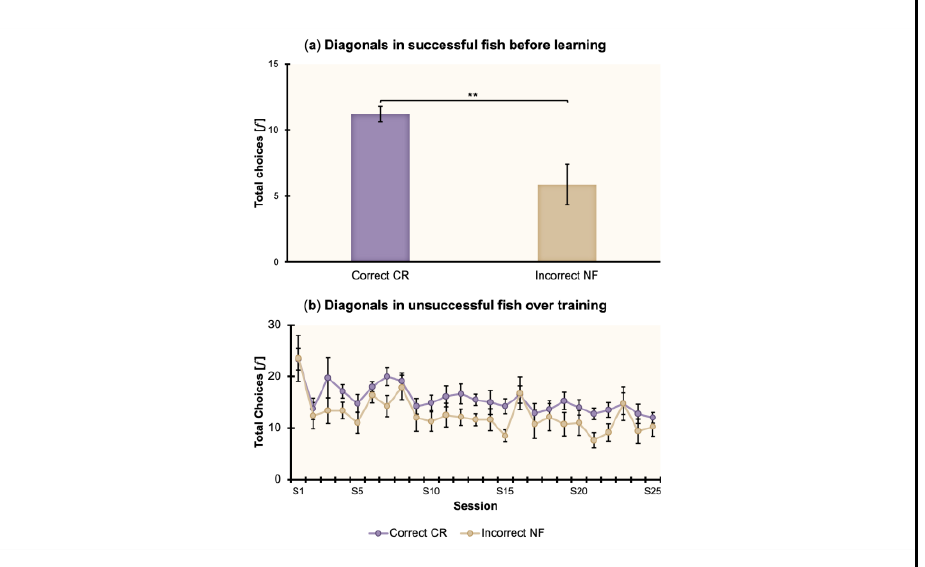
Figure 5. Total choices for the diagonals (geometry alone) in the 8 fish achieving the learning criterion ≥ 70% for C ( a ) and in the 8 fish not achieving it ( b ). Mean ± SEM are shown. Significant p values are indicated with asterisks (** p = 0.001).